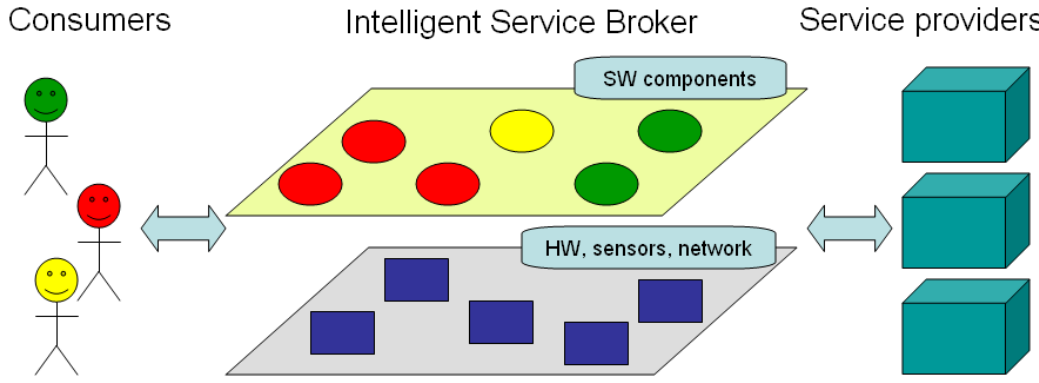
Figure 1. Concept architecture of the Intelligent Services Broker ISB. Similarly colored SW components represent clusters that serve to the equally marked consumers. SW – software, HW –